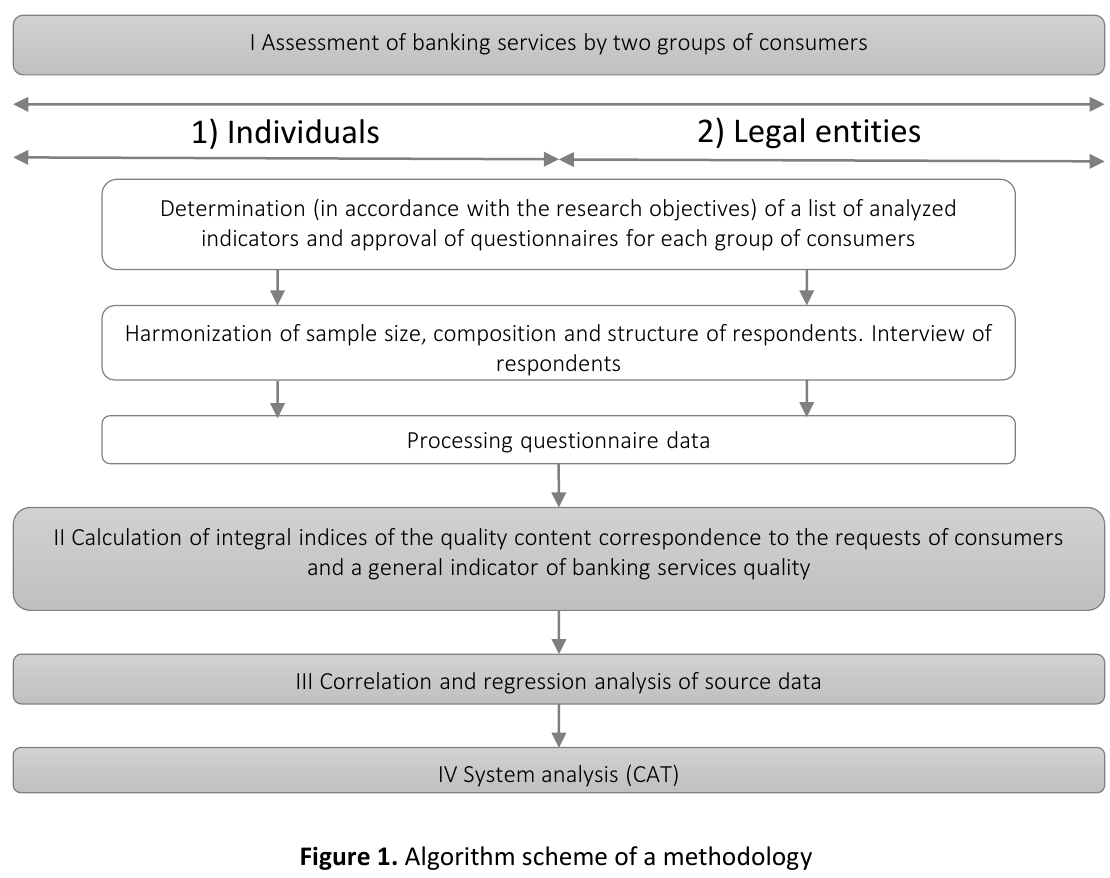
Figure 1. Algorithm scheme of a